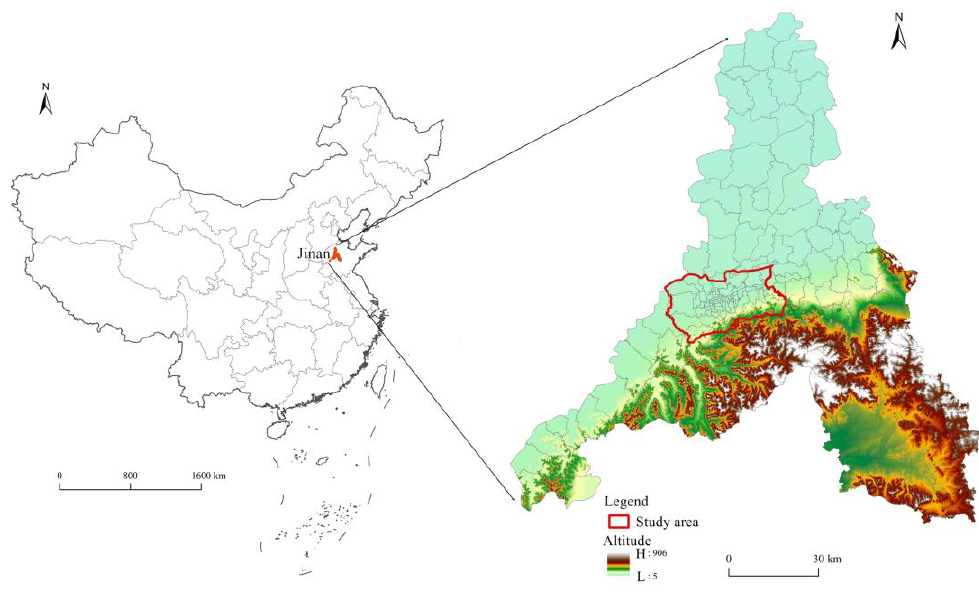
Figure 1. Study area.